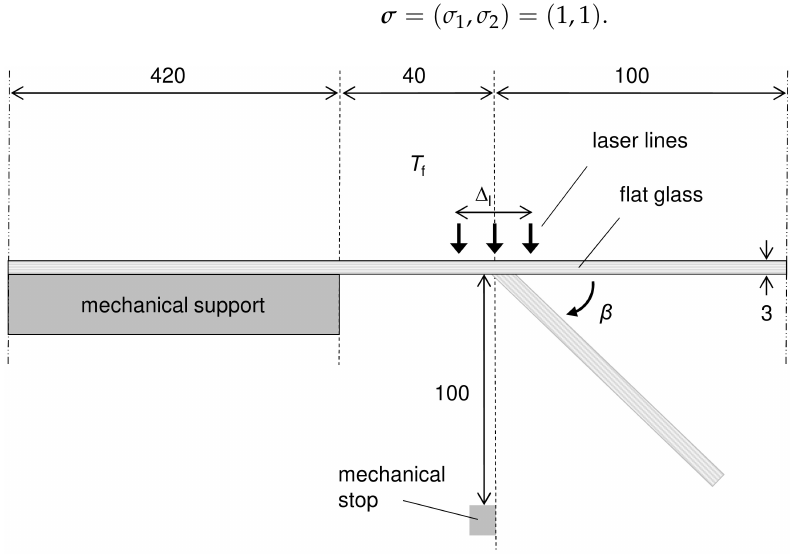
Figure 1. Side view of the laser glass bending process. Symbols: T f —furnace temperature, ∆ l — distance between the left- and right-most laser line, β —bending angle. Lengths are given in mm. Table 1. Ranges for the process variables of laser glass